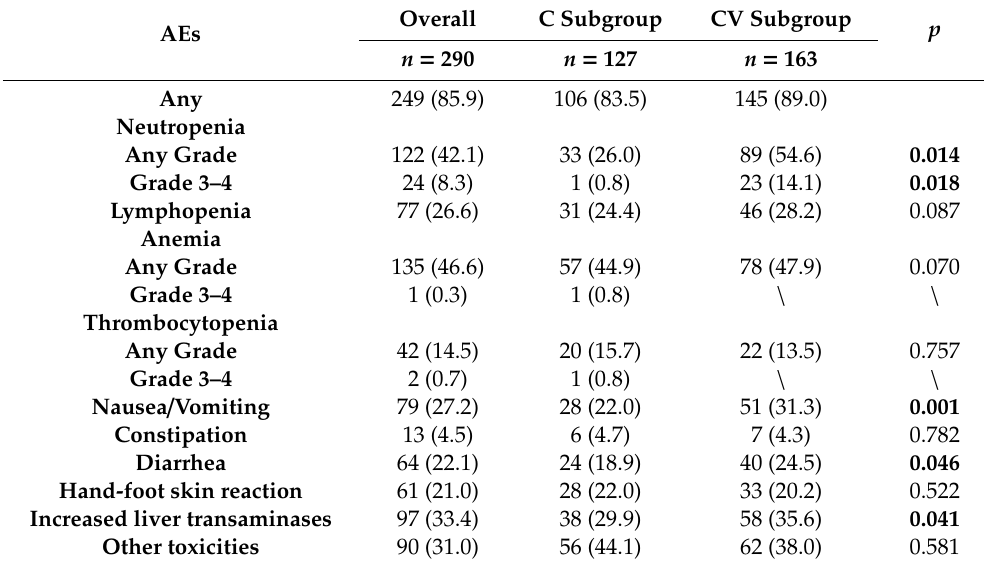
Table 2. Rate of AEs that occurred in patients treated with capecitabine or capecitabine-vinorelbine. Overall C AEs